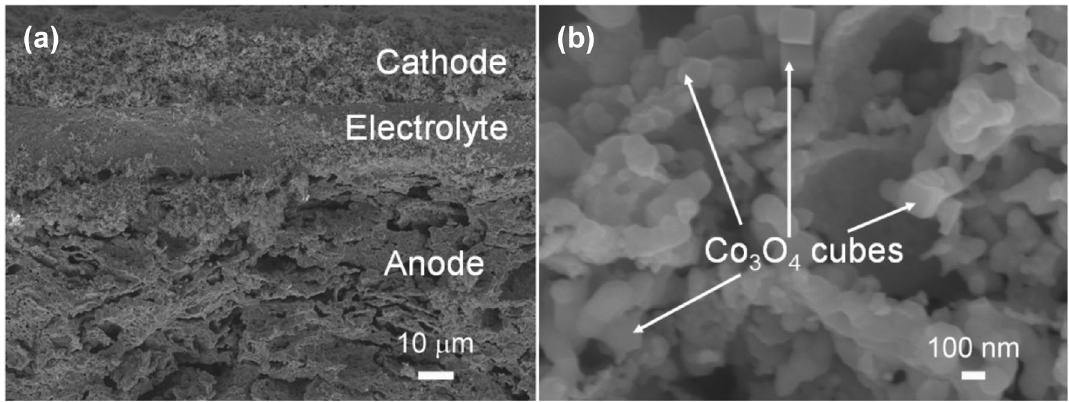
Fig. 3 SEM images of a the complete fuel cell and b an enlargement of the